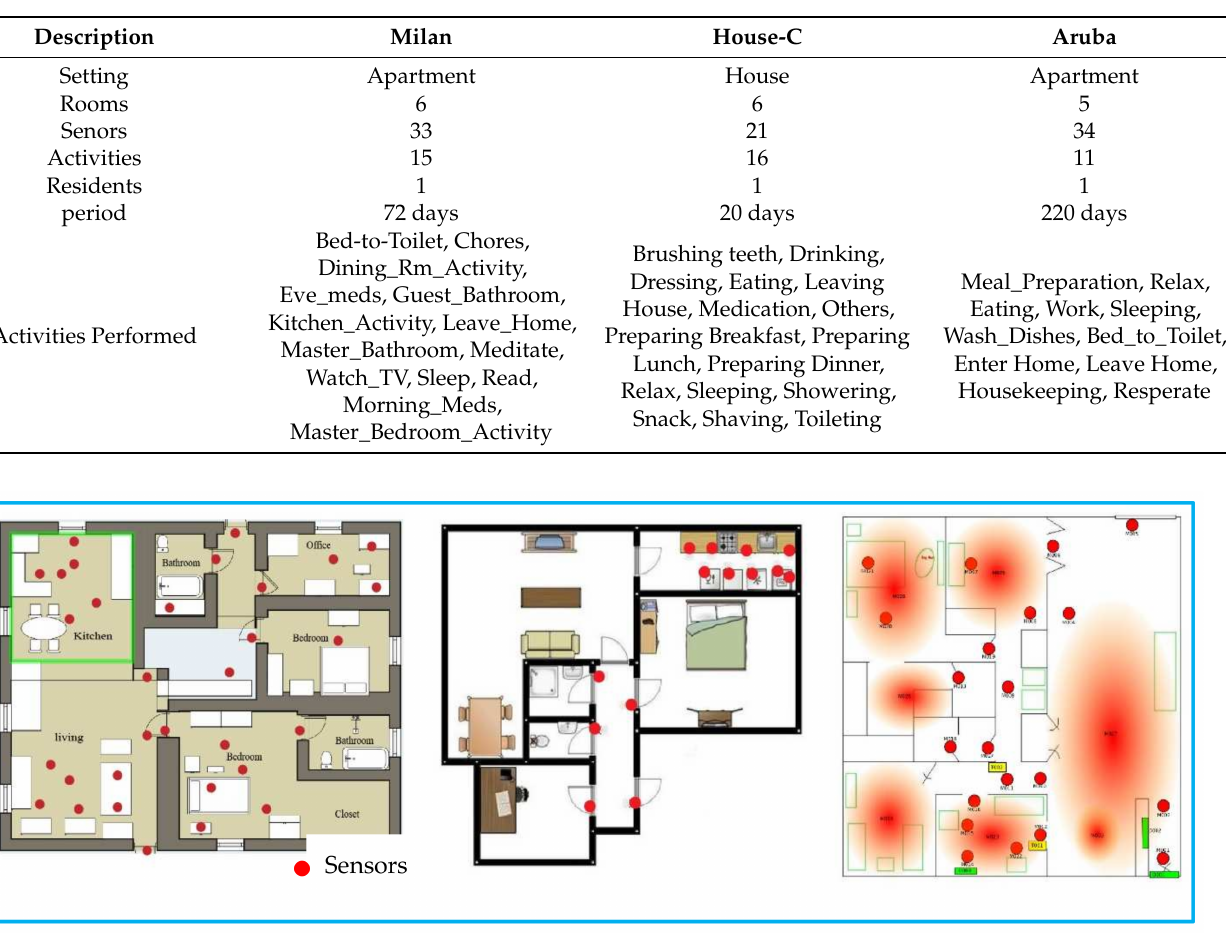
Figure 4. Floor Plan and Sensor